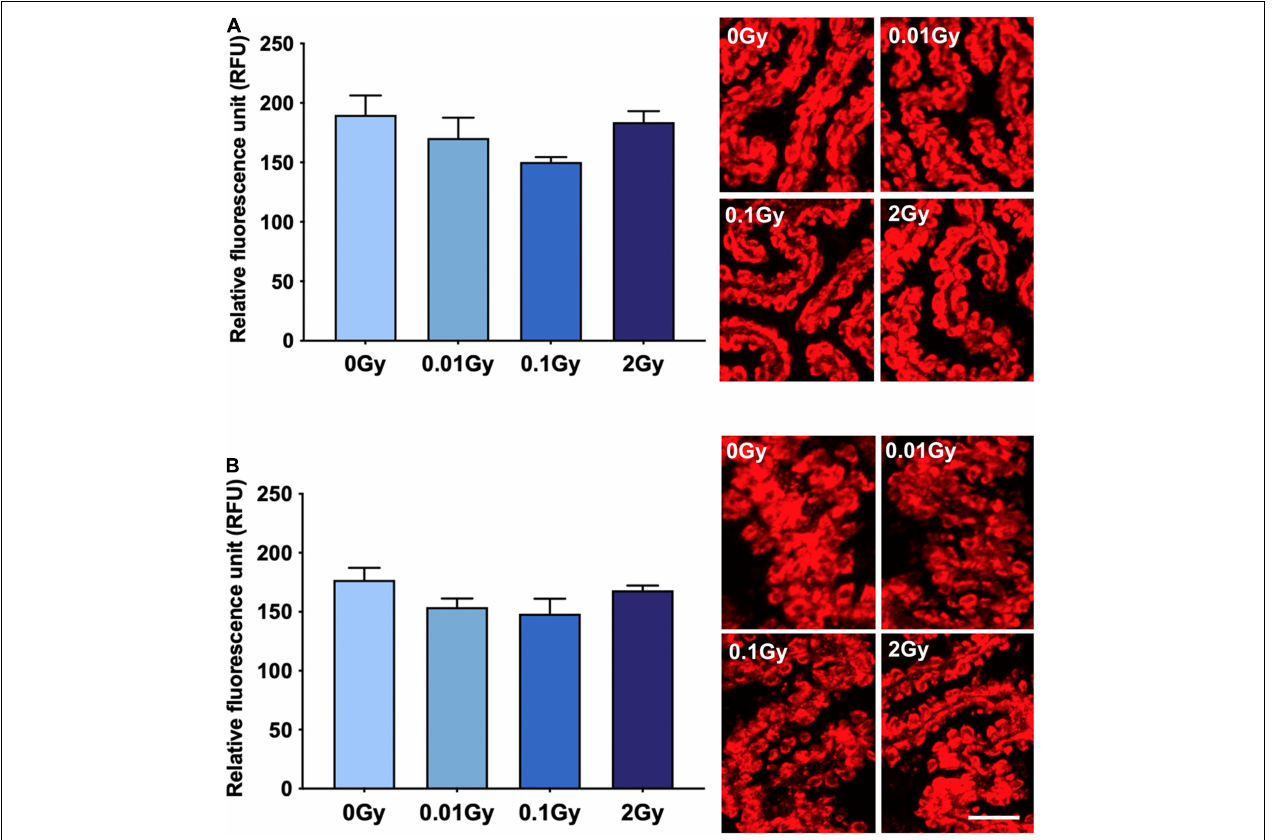
FIGURE 4 | TSPO expression levels in regions of high constitutive expression after gamma irradiation, as measured by fluorescence intensity, including the (A) third ventricle ependyma, and (B) lateral ventricle ependyma. Gamma irradiation did not significantly alter TSPO expression levels in these regions/cells, though a trend toward a decrease after 0.01 and 0.1 Gy was observed ( p > 0.05). n = 4–5 animals/group. Scale bar = 40 µ m.